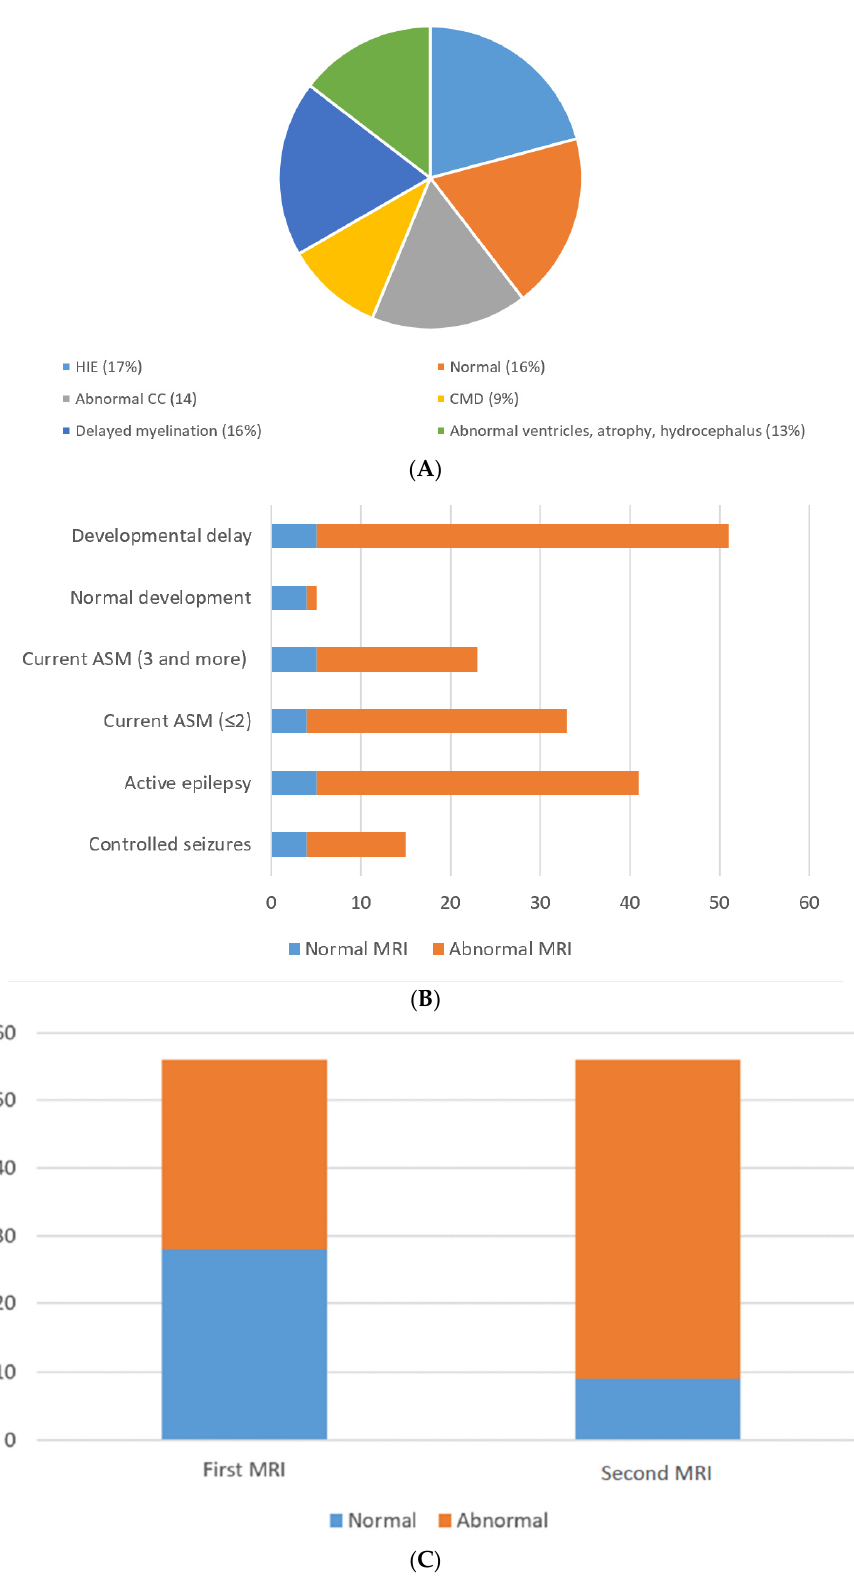
Figure 1. ( A ) MRI brain etiologies. ( B ) Normal and abnormal 2nd MRI compared to development, medications and epilepsy. ( C ) Normal and abnormal MRIs upon